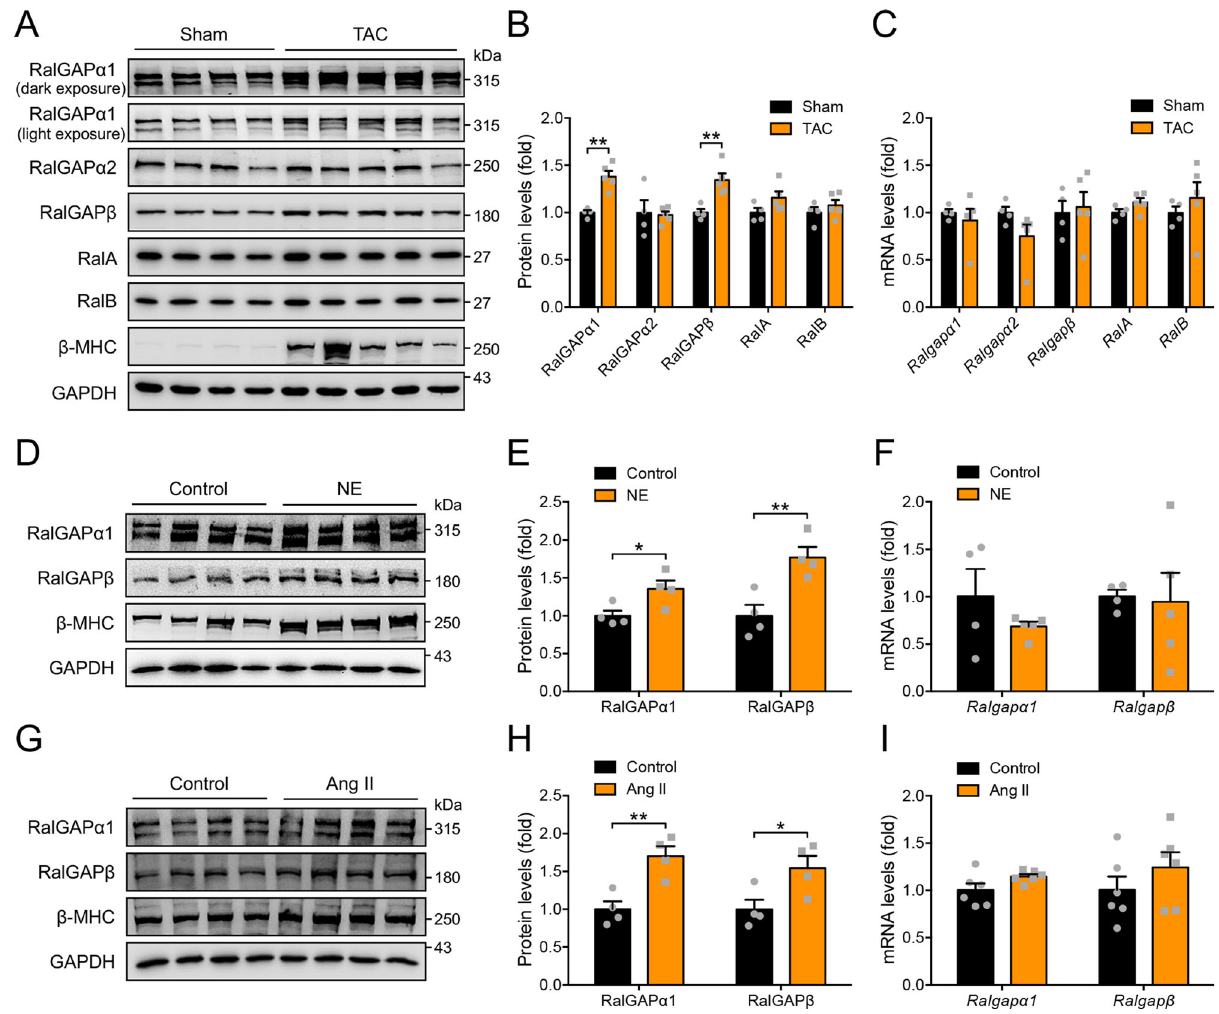
Fig. 1 | Expression of RalGAP − Ral signaling components in the heart and car- diomyocytes.A , B ProteinexpressionofRalGAPcomplexesandtheirdownstream RalsmallGproteinsintheheartsof2-month-oldWTmalemicethatweresubjected to TAC or sham operation for 12 days. GAPDH was used as a loading control. B quantitation of blots shown in A . n =4 (Sham) and 5 (TAC). p =0.0011 (RalGAP α 1), 0.843 (RalGAP α 2), 0.0055 (RalGAP β ), 0.113 (RalA) and 0.386 (RalB). C mRNA expression of RalGAPcomplexes and their downstreamRal small G proteins in the heart of2-month-oldWT malemicethat weresubjected to TAC orsham operation for12days. n =4(Sham)and5(TAC). p =0.578( Ralgap α 1 ),0.138( Ralgap α 2 ),0.792 ( Ralgap β ), 0.112 ( RalA ) and 0.457 ( RalB ). D , E Protein expression of RalGAP α 1/ β complexes and β -MHC in NRVCs stimulated with or without norepinephrine (NE).